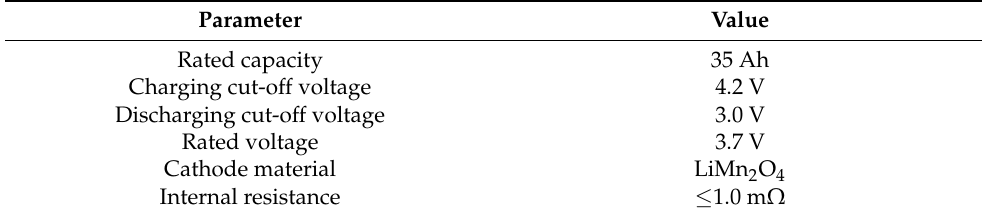
Table 3. Lithium manganese oxide battery parameters.